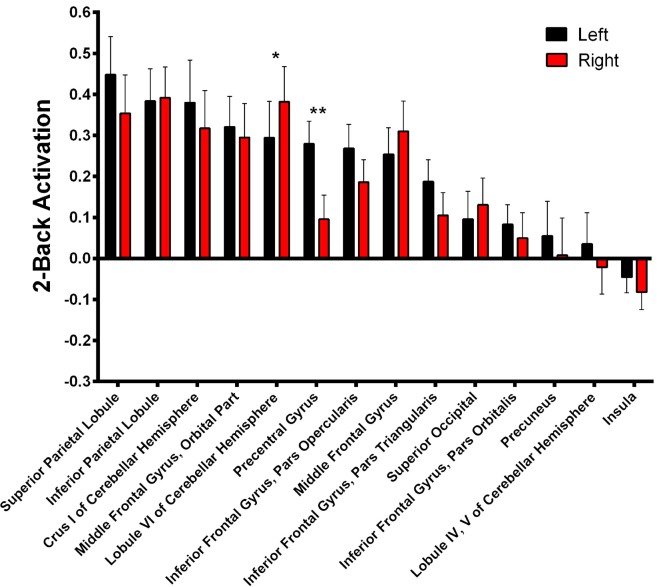
2-Back-related BOLD asymmetries. Comparison between left and right activations/deactivations during 2-Back performance. *α < 0.05, **α < 0.01 in Bonferroni-corrected paired comparisons.